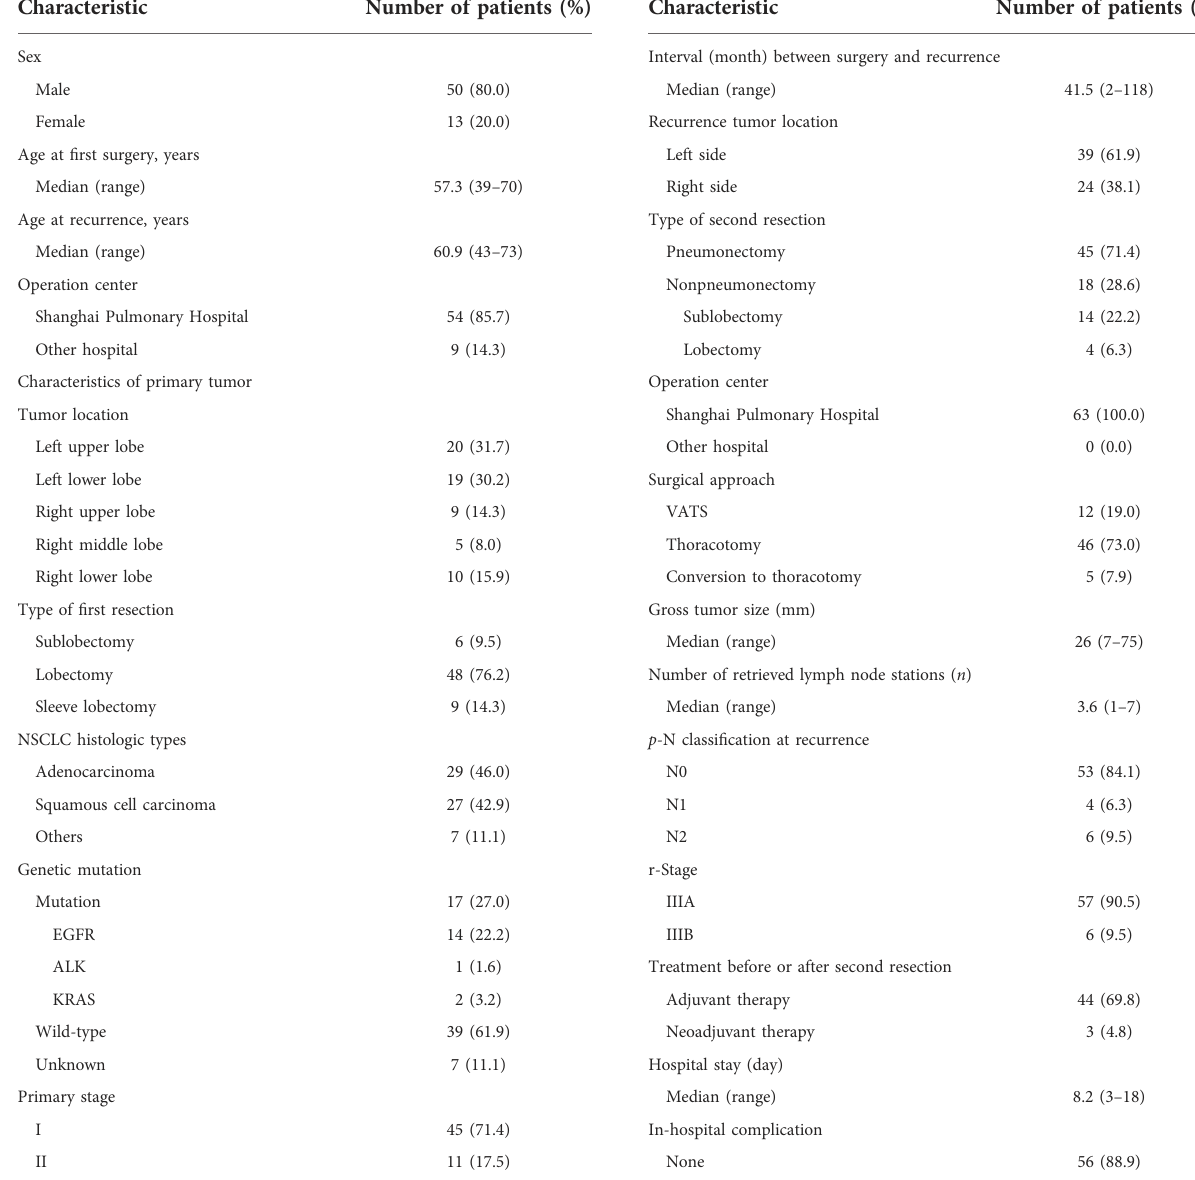
TABLE 1 Patients ’ characteristics ( n =63). TABLE 2 Characteristics of recurrence ( n